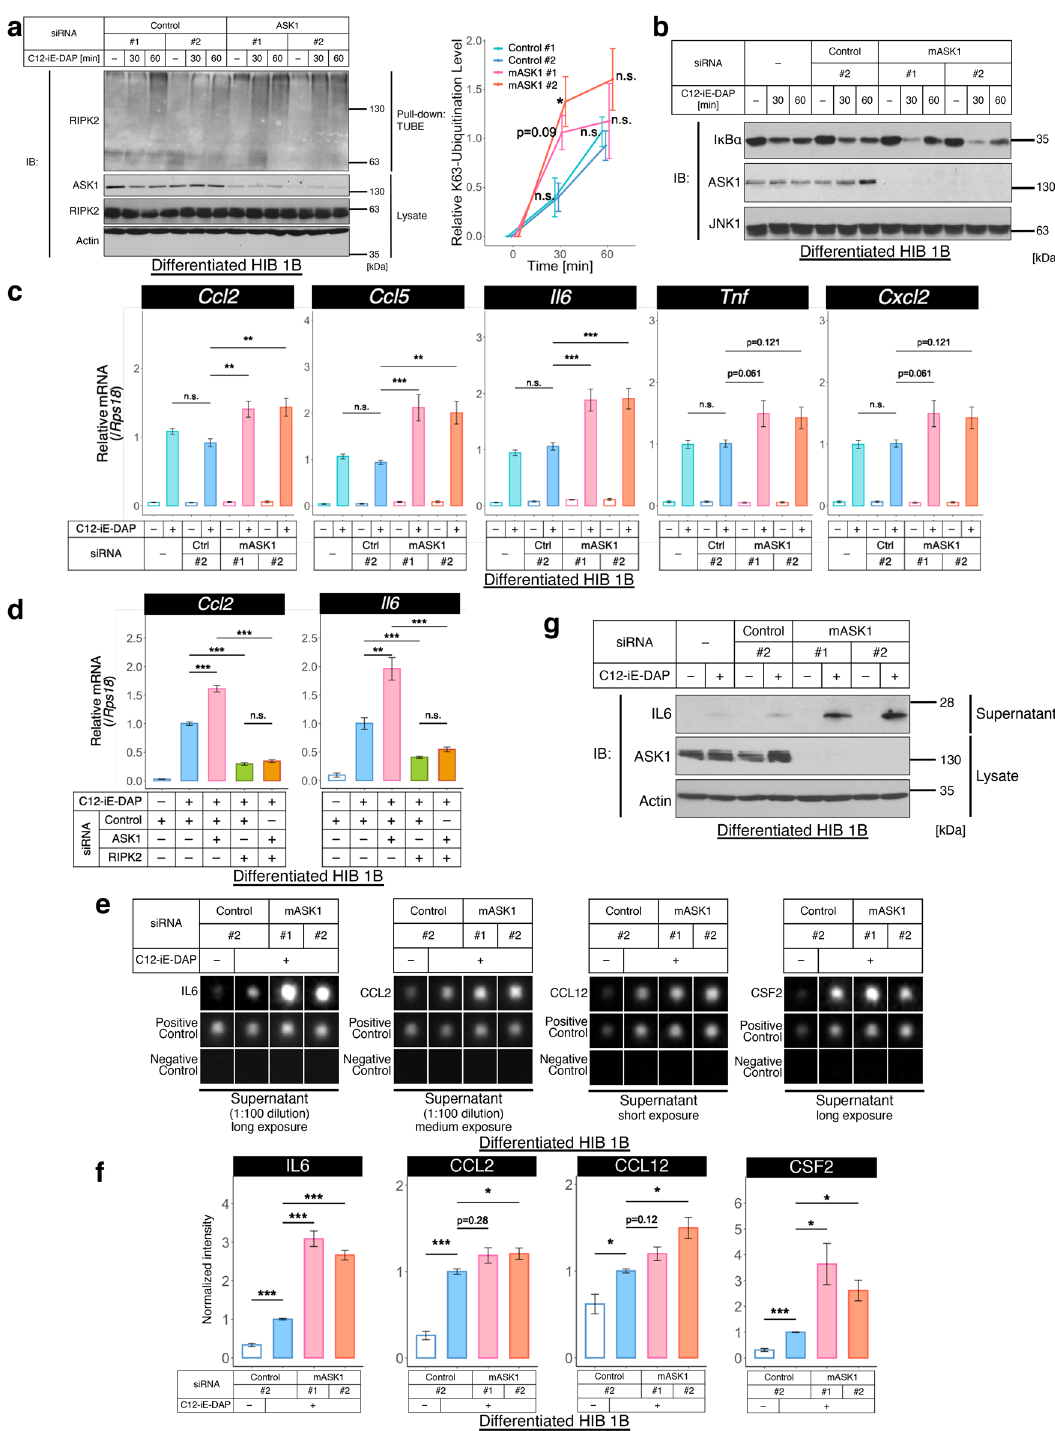
Figure 3. ASK1 suppresses the NOD-RIPK2 pathway and cytokine induction in brown adipocytes. ( a,b ) Effects of ASK1 knockdown on the K63-polyubiquitination of RIPK2 ( a ) or the activation of the NOD-RIPK2 pathway ( b ) in brown adipocytes. ASK1-knockdown HIB 1B cells were treated with C12-iE-DAP (10 µg/mL) for the indicated times. The right graph in ( a ) indicates the quantification of western blot, and statistical analysis was performed against Control #2 at each time point. JNK loading control in ( b ). ( c,d ) Effects of ASK1 knockdown ( c ) or ASK1/RIPK2 double knockdown ( d ) on the relative mRNA levels of inflammatory cytokines under NOD-RIPK2 pathway activation. Differentiated HIB 1B cells were treated with C12-iE-DAP (10 µg/mL, 6 h). ( e–g ) Effects of ASK1 knockdown on cytokine secretion from NOD-RIPK2 pathway-activated cells. Supernatant ( e ), or supernatant and cell lysates ( g ) from C12-iE-DAP (10 µg/mL, 8 h)-treated HIB 1B cells were subjected to cytokine antibody array ( e ) or immunoblotting ( g ), respectively. The images of cytokine antibody array were quantified in ( f ). See Supplementary Fig. S1 for the other cytokines. Data are represented as the mean ± SEM. n = 4 in ( a ), n = 9 (pooled from 3 independent experiments) in ( c ), n = 8 (pooled from 4 independent experiments) in ( d ), n = 6 (pooled from 3 independent experiments) for IL6, CCL2 and n = 8 (pooled from 4 independent experiments) for CCL12, CSF2 in ( f ). * P < 0.05, ** P < 0.01, *** P < 0.001, n.s. not significant, according to two-tailed Dunnett’s test ( a,c ) or two-tailed Welch’s t -test with the Bonferroni correction ( d,f ). Ctrl